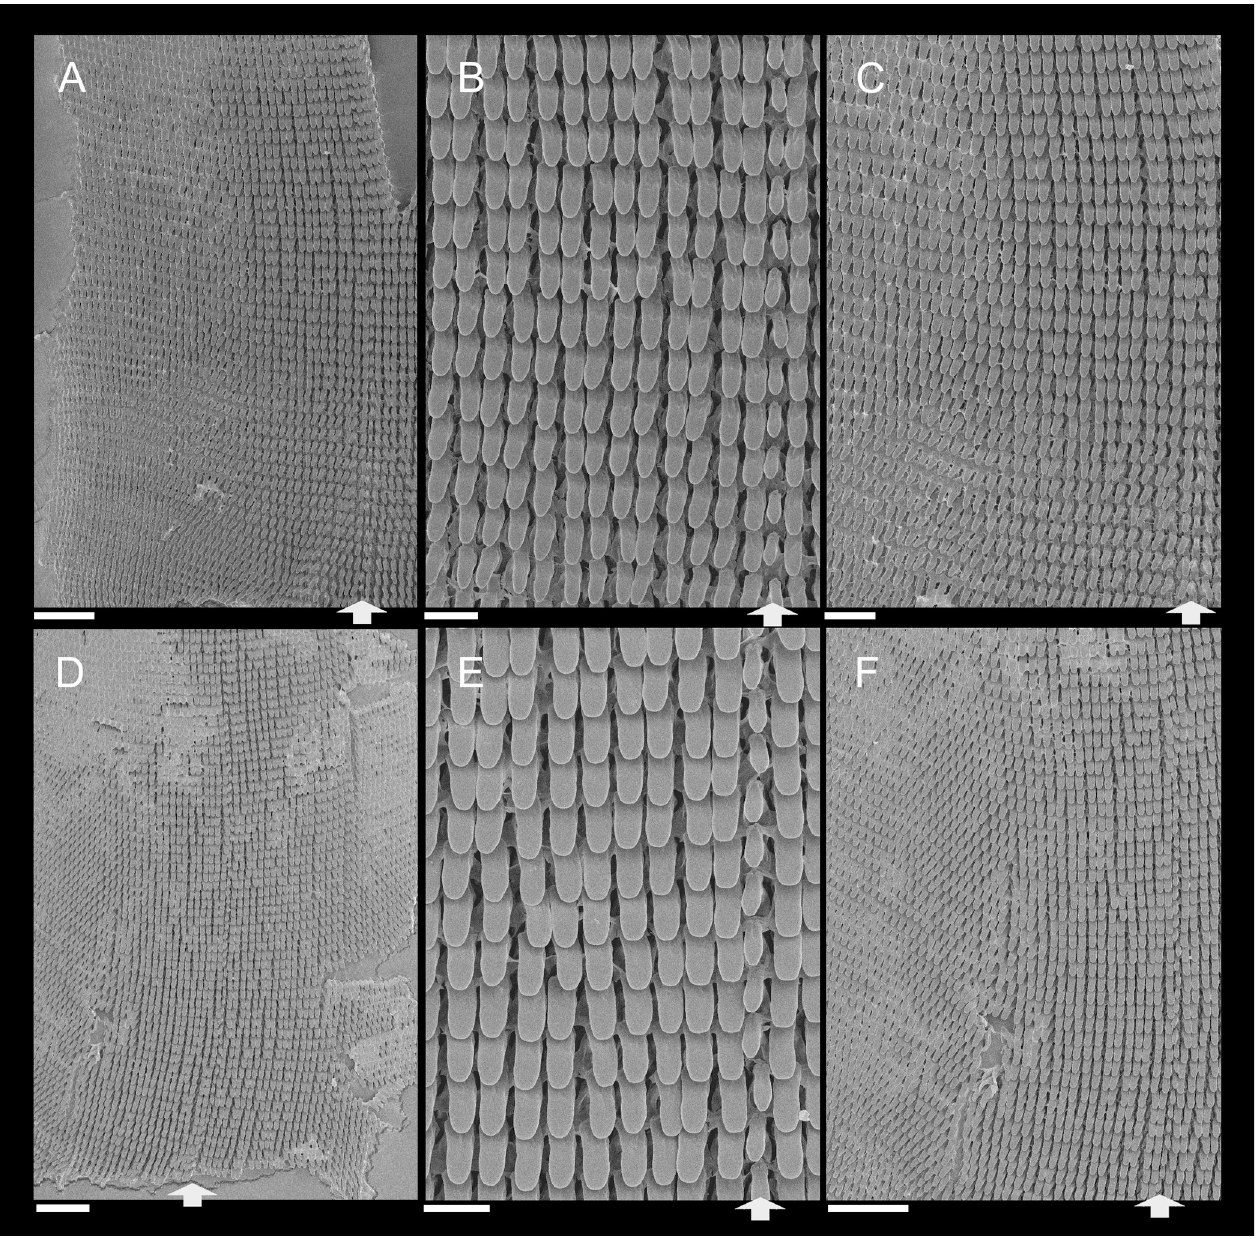
Fig 11. Anthinus vailanti , radulae in SEM, Paratypes MZSP 152118, 2 specimens. (A) wider vision, scale = 200 μ m; (B) detail of central region, scale = 50 μ m; (C) wide left view, scale = 100 μ m; (D) wide view of another specimen, scale = 200 μ m; (E) detail of central region, scale = 50 μ m; (F) wide left view, scale = 200 μ m. White arrows indicating rachidian